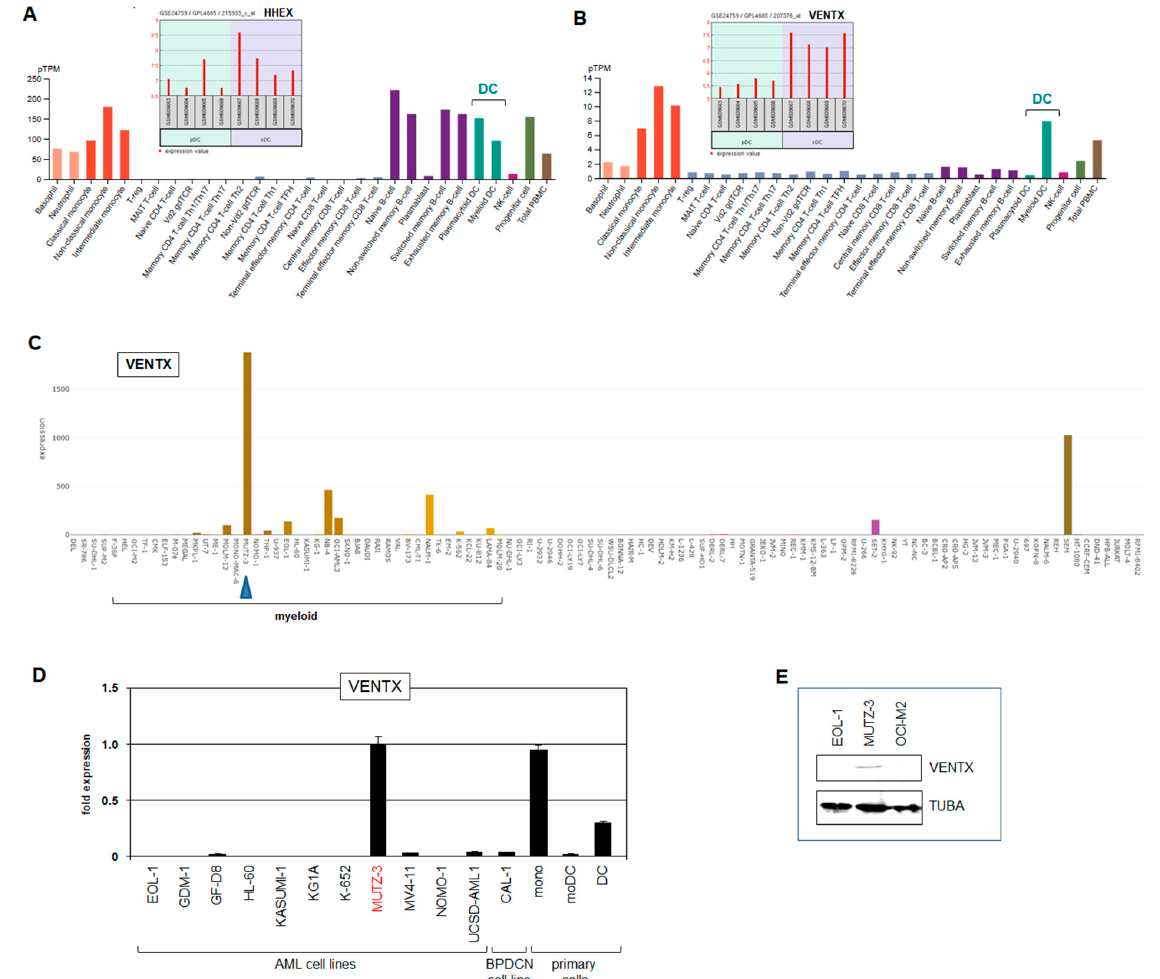
Figure 1. VENTX and HHEX expression. Expression analyses of NKL homeobox genes HHEX ( A ) and VENTX ( B ) were performed using public datasets from GEO (GSE24759) and the Human Protein Atlas. The data show that HHEX is active in both pDC and cDC entities while VENTX is expressed in cDCs but not pDCs. ( C ) VENTX expression analysis was performed using RNA-seq dataset LL-100. Conspicuous VENTX levels are shown for AML cell line MUTZ-3 (blue arrow head). The myeloid cell lines are indicated. ( D ) RQ-PCR analysis of VENTX in selected AML and BPDCN cell lines and primary cells including monocytes (mono), monocyte-derived DCs (moDC), and DCs. The indicated fold expression levels are relative to MUTZ-3 which was set to unity. ( E ) Western blot analysis of VENTX and alpha-Tubulin (TUBA) which served as loading control. VENTX protein was detected in MUTZ-3 while two control cell lines tested